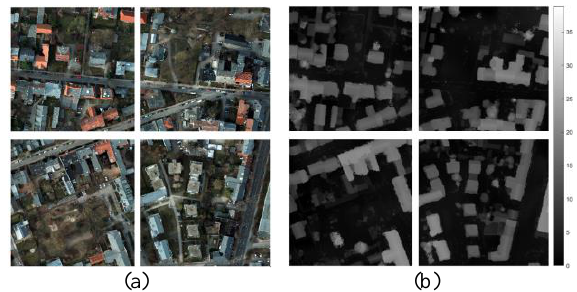
Figure 4. The training samples including ortho-images (a); and the corresponding nDSMs